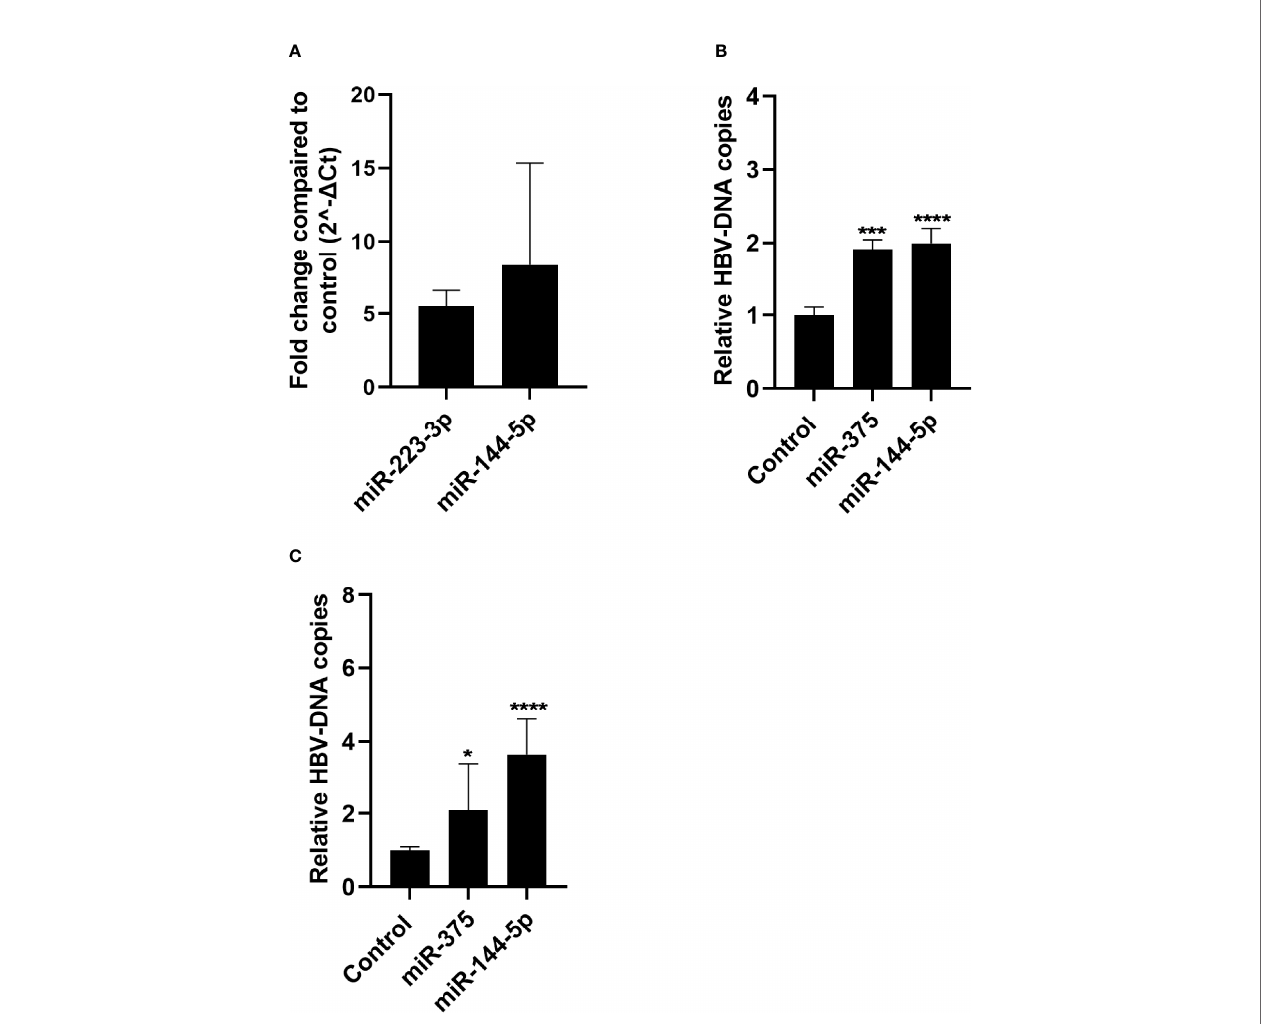
FIGURE 4 | Effect of miR-144-5p and miR-375 overexpression on HBV replication in vitro . miR-144-5p and miR-375 were overexpressed using a lentiviral vector in HepG2.2.15 (A) and HepAD38 (B) cells. HBV-DNA levels were measured in the supernatant. HBV-DNA levels shown were corrected for cell viability analysed by MTT assay. (C) Overexpression of miR-144-5p and miR-375 by lentiviral transduction in HepG2.2.15 cells was determined by qPCR and is expressed as fold increase as compared to the GFP control. Data is presented as median and interquartile range. Differences between the groups were determined by Mann Whitney U test. *: p<0.05, ***: p<0.001, ****: